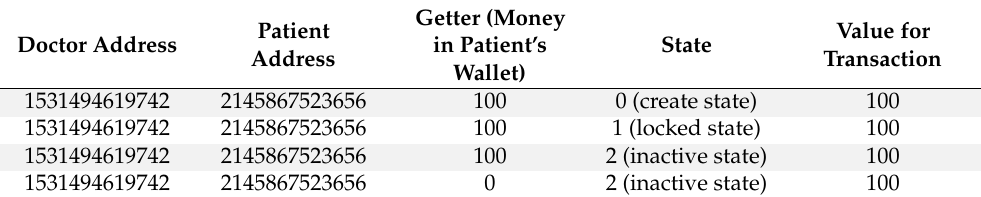
Table 10. Smart contract states.